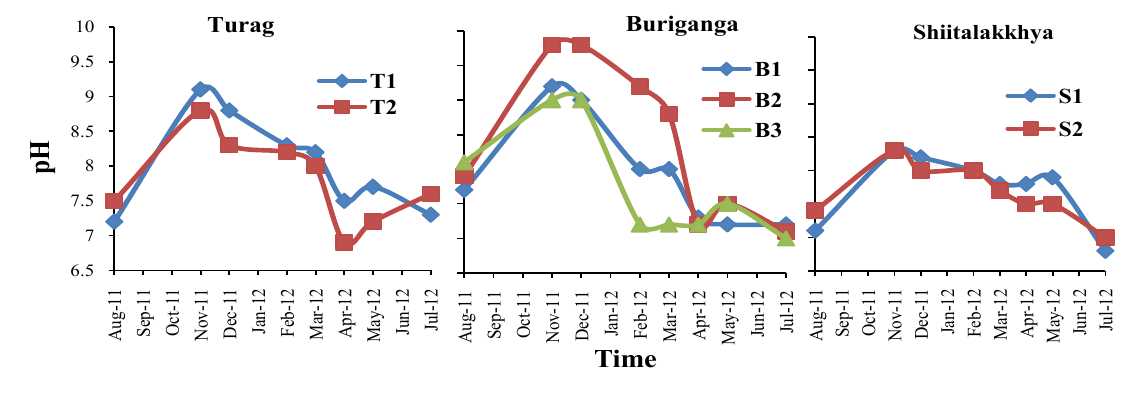
Figure 4. The pH values of the samples from the water of three different rivers around Dhaka